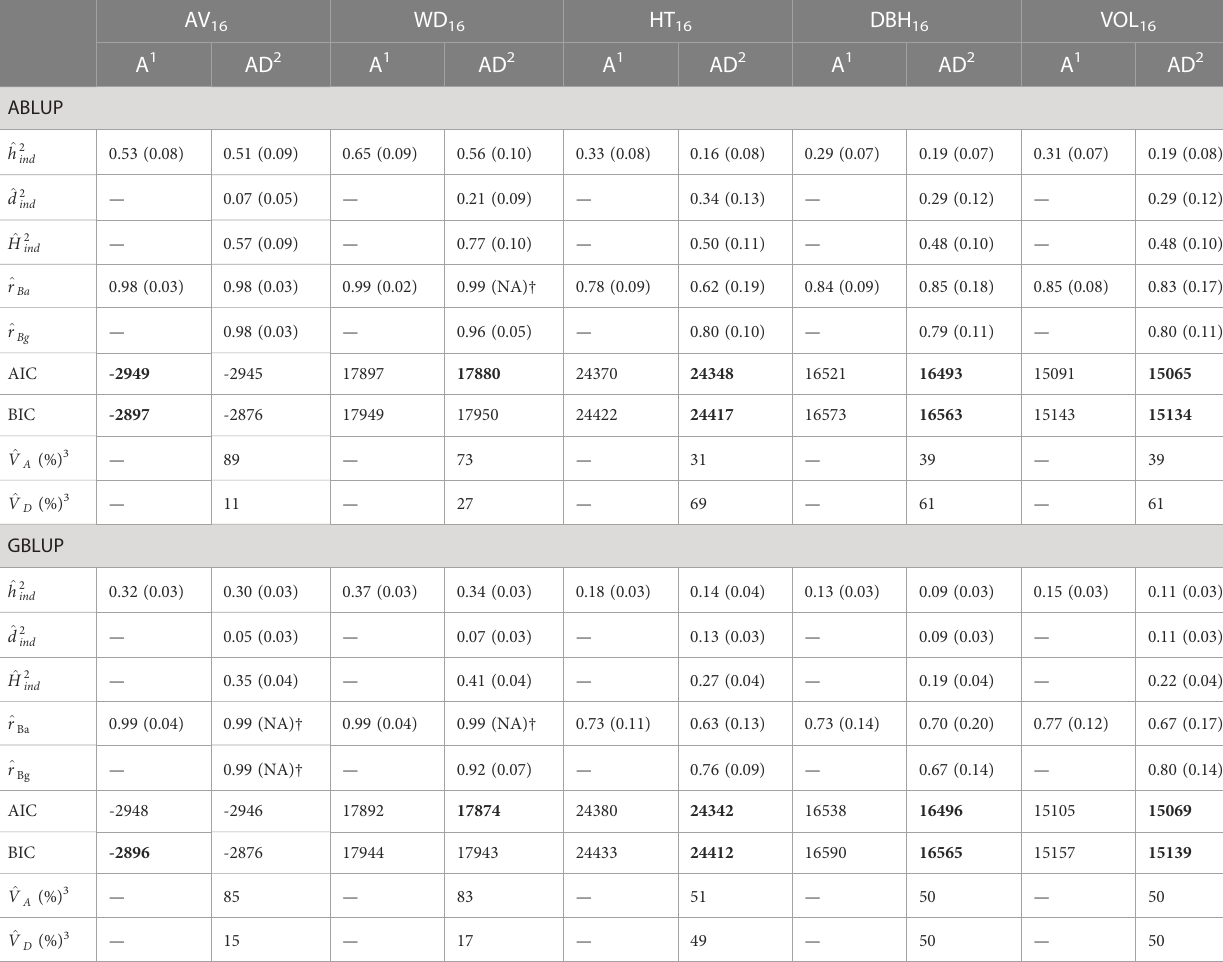
TABLE 3 For the complete dataset 1, across-site genetic parameters estimated using the ABLUP and GBLUP additive (A) and additive-dominance (AD)